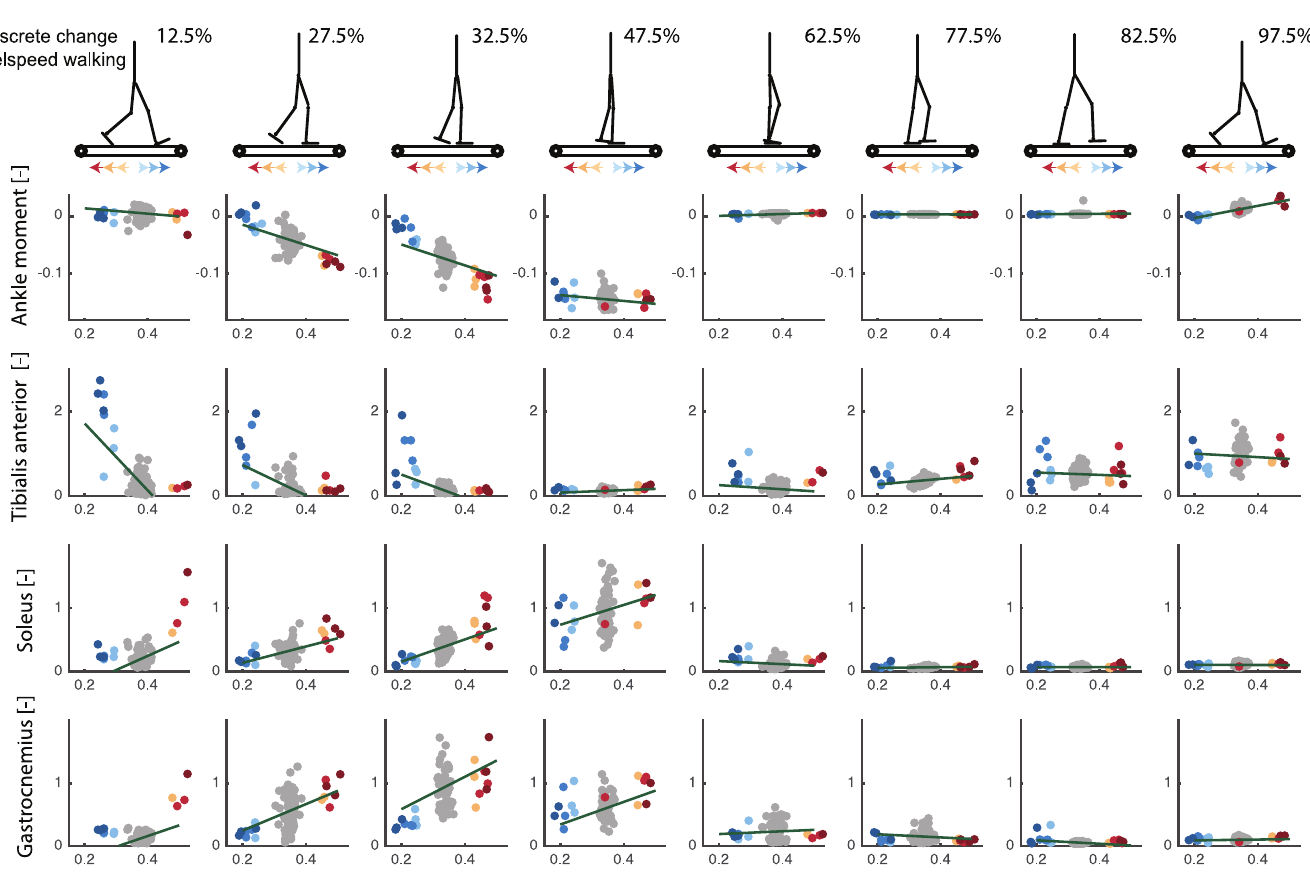
Fig 6. Discrete treadmill perturbations walking (data from [17]). Representative example of the relation between deviations in delayed center of mass velocity and reactive joint moments (row 1) and activity of the tibialis anterior (row 2), soleus (row 3) and gastrocnemius (row 4) in response to perturbations during walking. Perturbations were applied at four instances during the stance phase of the left leg resulting in eight responses at joint level when combining data of the left and right leg (e.g. right leg is in swing during mid-stance of the left leg). Unperturbed walking is visualised in gray, increases in belt speed (i.e. forward fall) in red and decrease in belt speed in blue (i.e. backward fall). Note that the total joint moment and muscle activity rather than the deviation from the average unperturbed data is shown here to also provide information on the muscle activity and joint moments during unperturbed walking.